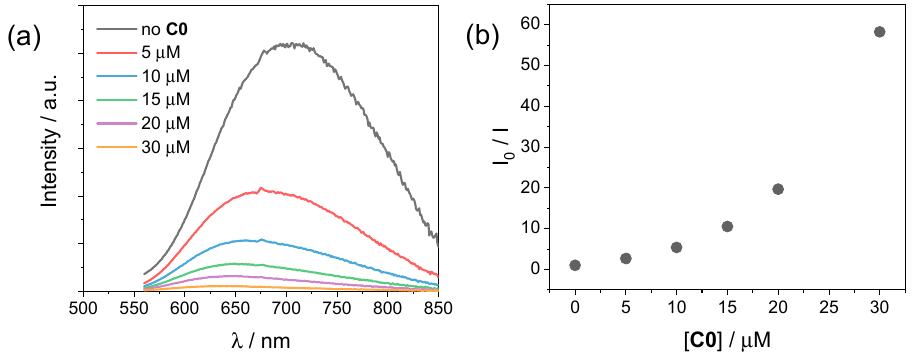
Figure 5. ( a ) Luminescence spectra (excitation at 450 nm) of CuInS2@ZnS QDs in water upon addition of 0–30 µM C0 ; ( b ) plot of the I 0 /I ratio vs. C0 concentration.